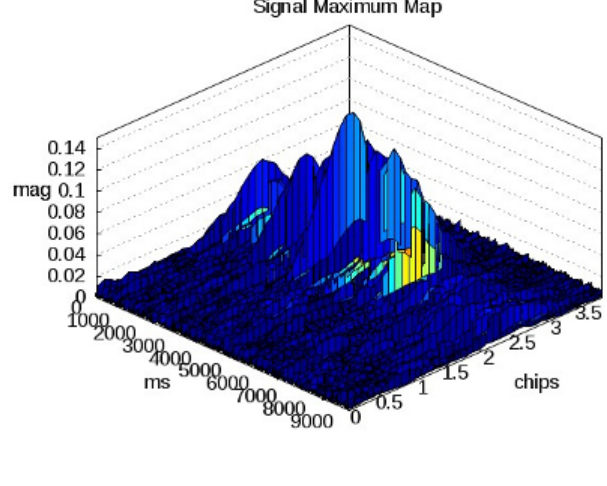
Figure 11. Delay waveform over 9 seconds for the June 23 2005 reflection